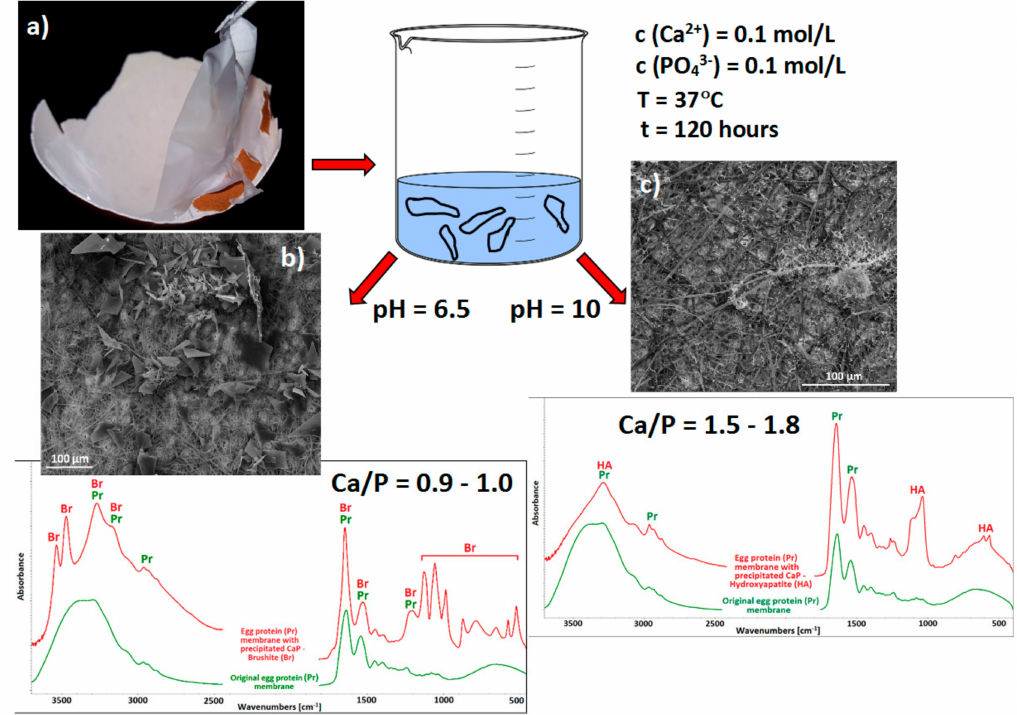
Figure 3. ( a ) Eggshell biomembrane used as a template for CaP precipitation under physiological conditions applying two di ff erent pH values. SEM and FTIR analysis ( b ) for pH = 6.5 and ( c ) for pH = 10. Pr = protein; HA = hydroxyapatite; Br =